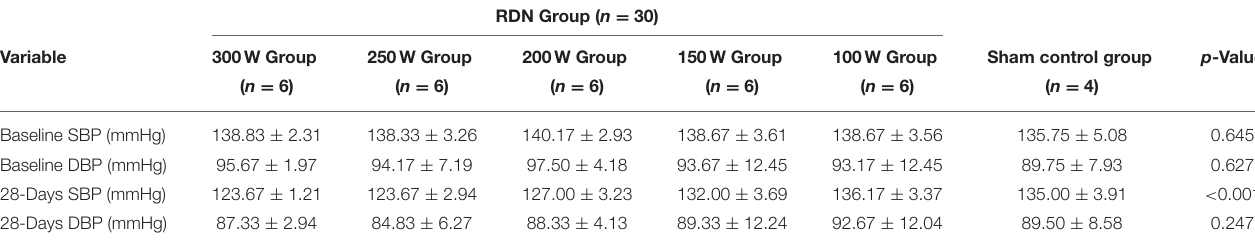
TABLE 1 | Mean blood pressure (BP) in renal sympathetic denervation (RDN) and sham control groups at baseline and day 28. RDN Group ( n = 30)